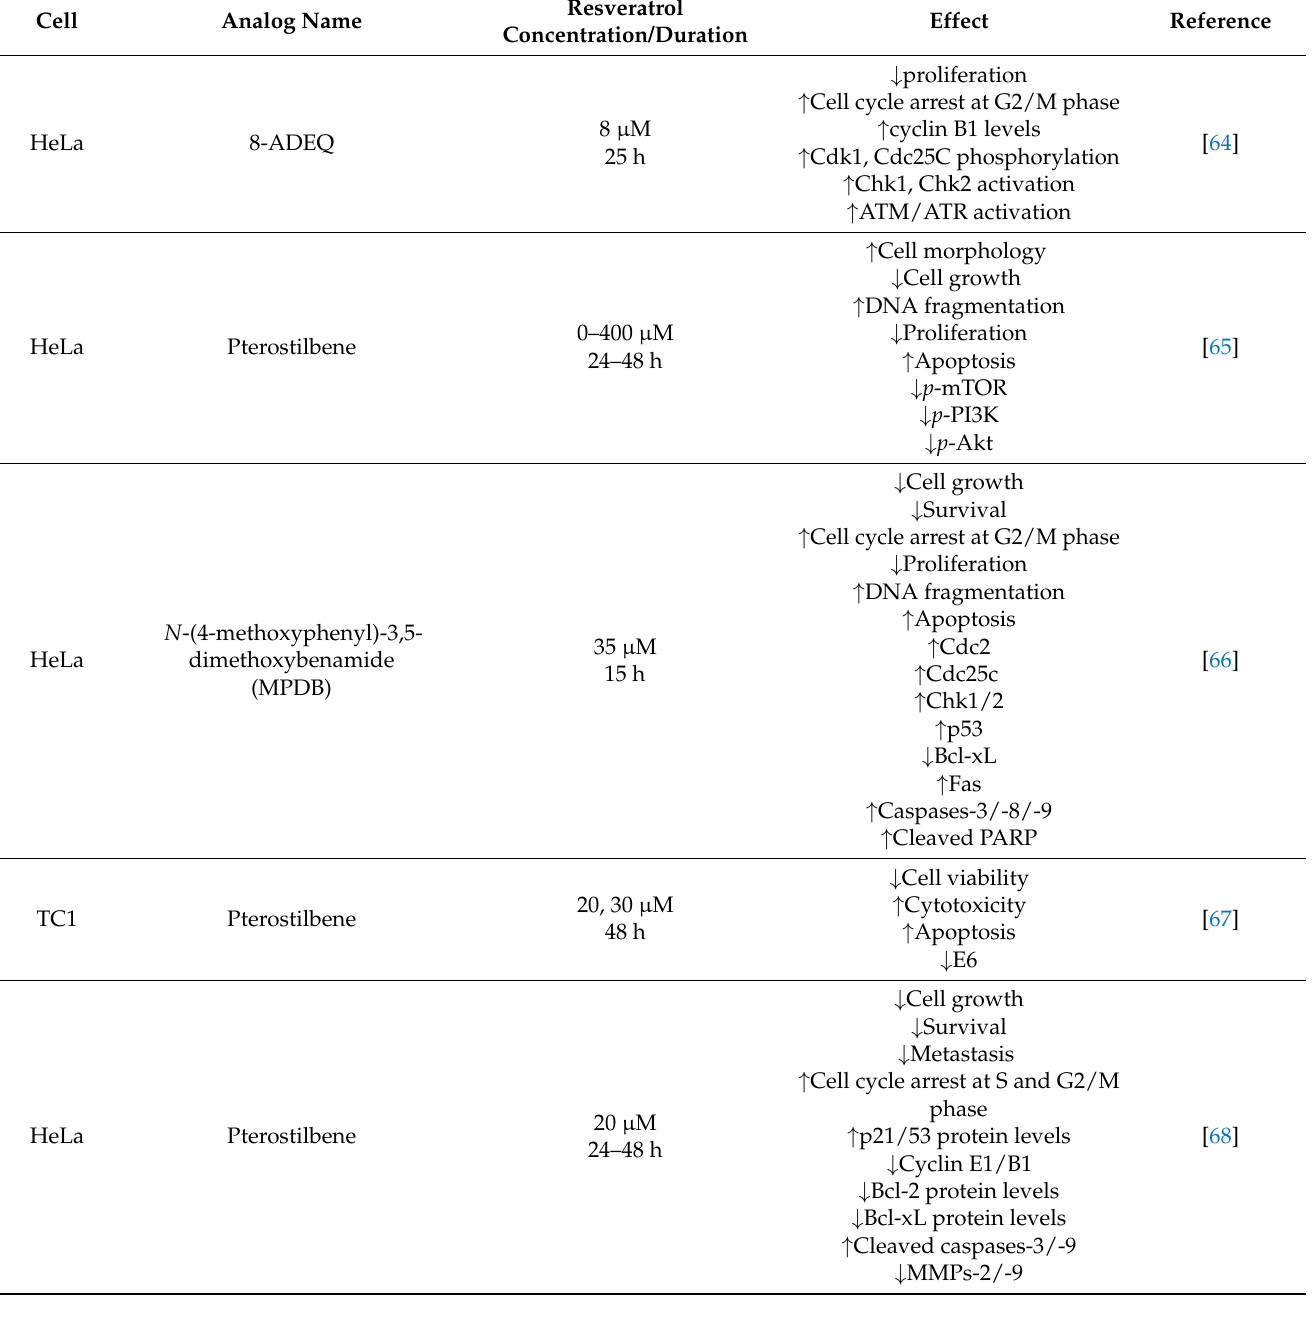
Table 2. Effects of resveratrol analogs against cervical cancer: in vitro